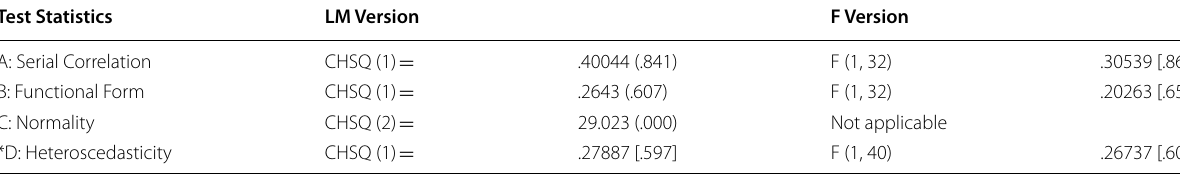
Source Computed by the Authors using Microfit